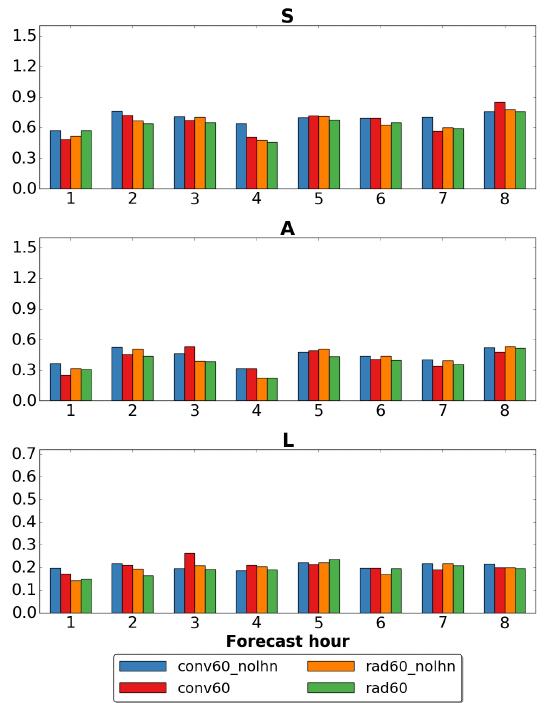
Figure 5. Average of the absolute value of each component of SAL over the 22 forecasts initialized from conv60_nolhn (blue), conv60 (red), rad60_nolhn (orange) and rad60 (green) analyses. Objects are selected using a threshold of 1mm in hourly accumulated precipita- tion fields. Cases in which the observed precipitation field consists of less than 1000 points are not taken into account in the average.